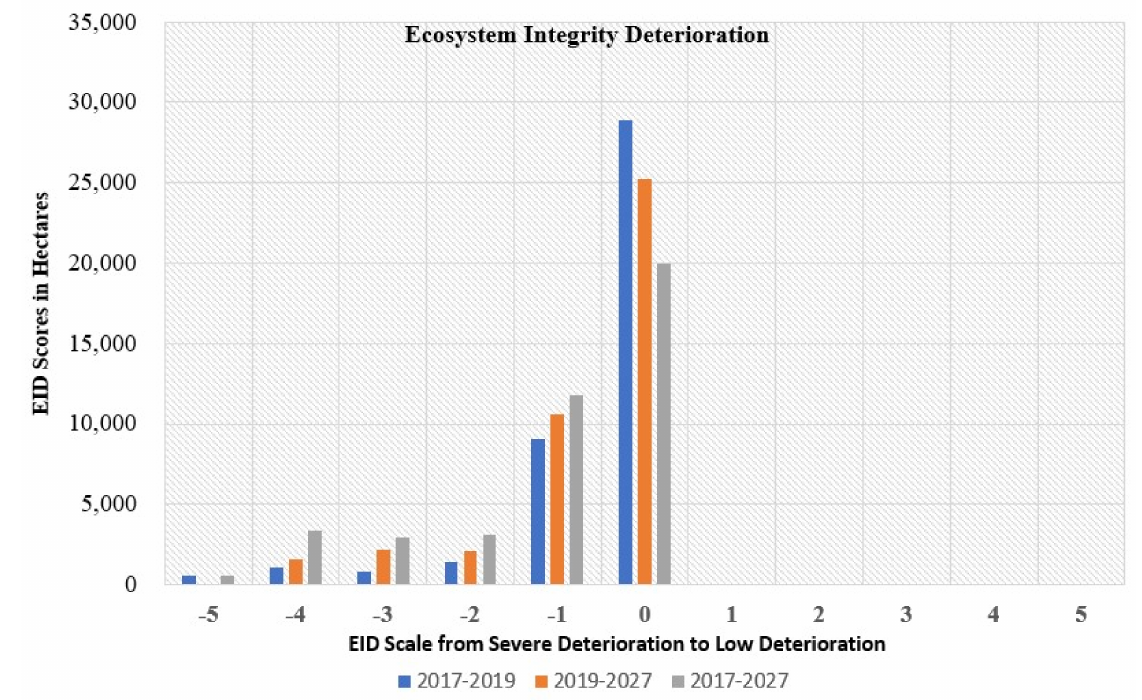
Figure 10. Areas depleted from different ecosystem integrity